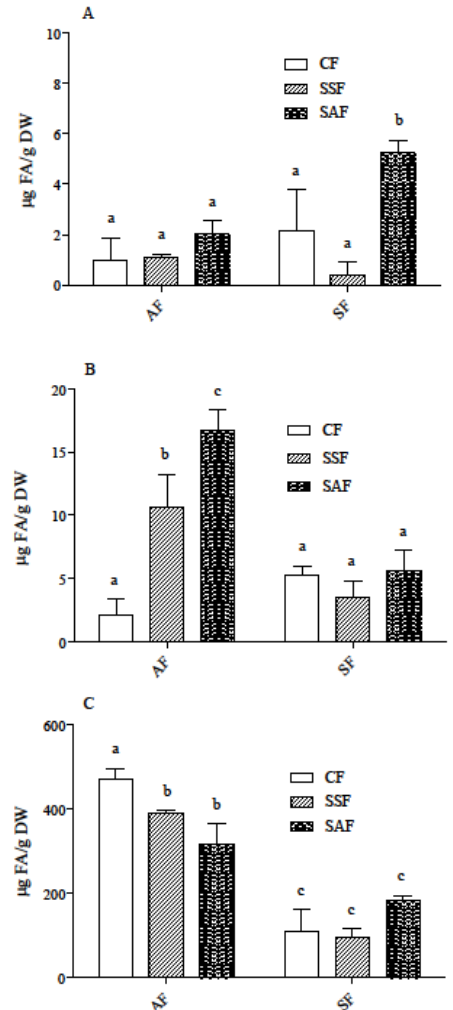
Figure 3. Ferulic acid content in the FREE ( A ), SC ( B ), and IB ( C ) fractions obtained from AF and SF breads prepared by CF or SSF or SAF as the starter flour. Results are the mean ± SD of two independent experiments with duplicate samples. Different letters indicate significant differences at p < 0.05. AF = ancient flour; SF = standard flour; CF = conventional fermentation; SAF = sourdough obtained from ancient flour; SSF = sourdough obtained from standard flour.